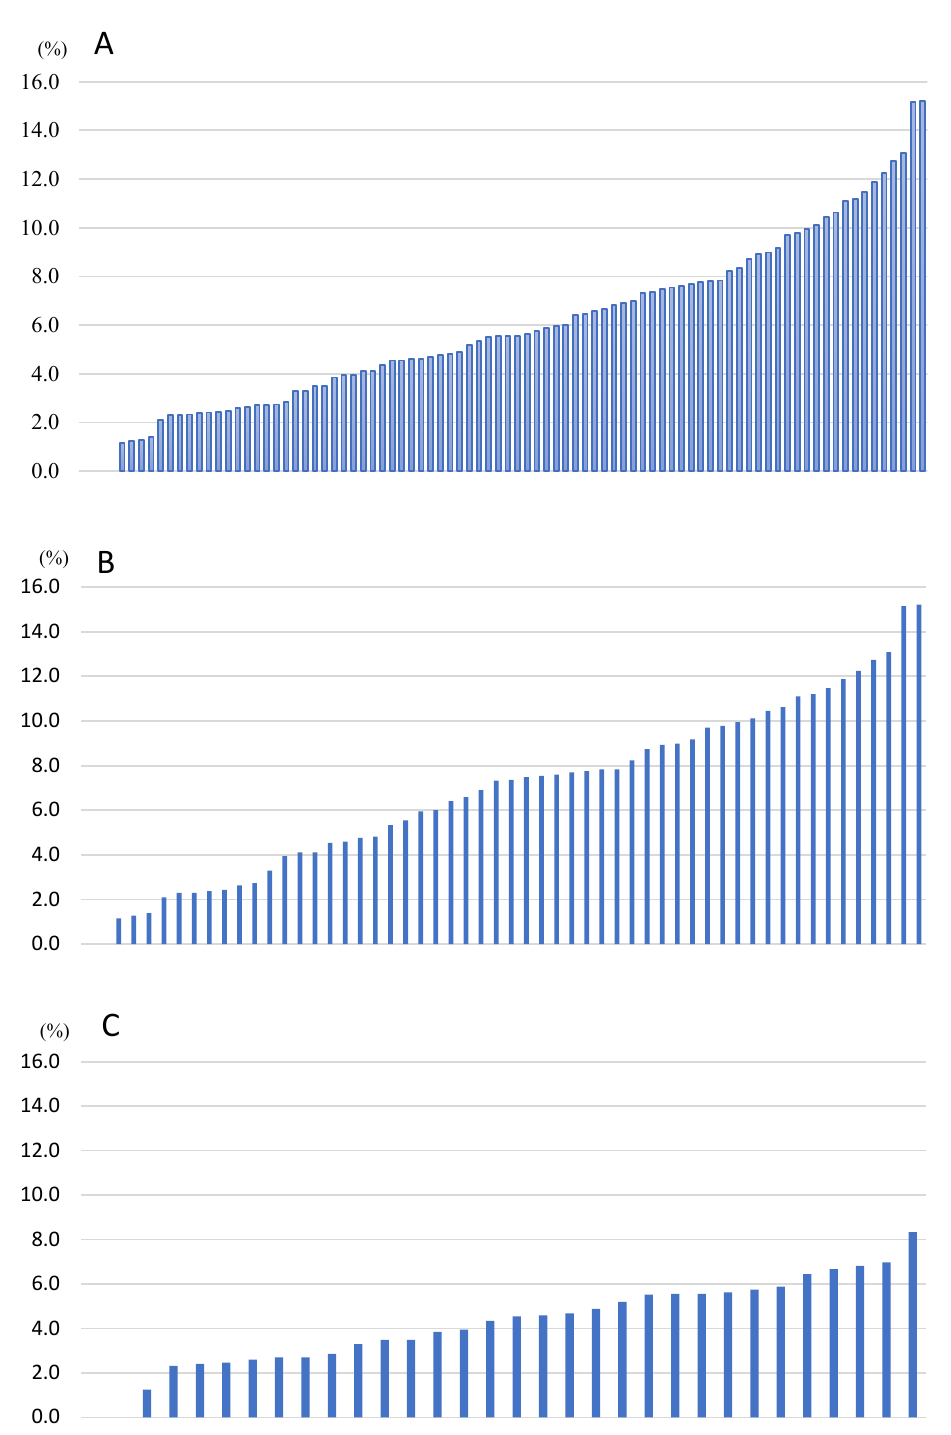
Figure 2. Prevalence rates of homebound status on older adultsThe prevalence rates in each community was represented from low to high prevalence among all analyzed 88 communities: (a) 52 communities in rural areas; (b) 32 in urban areas; and